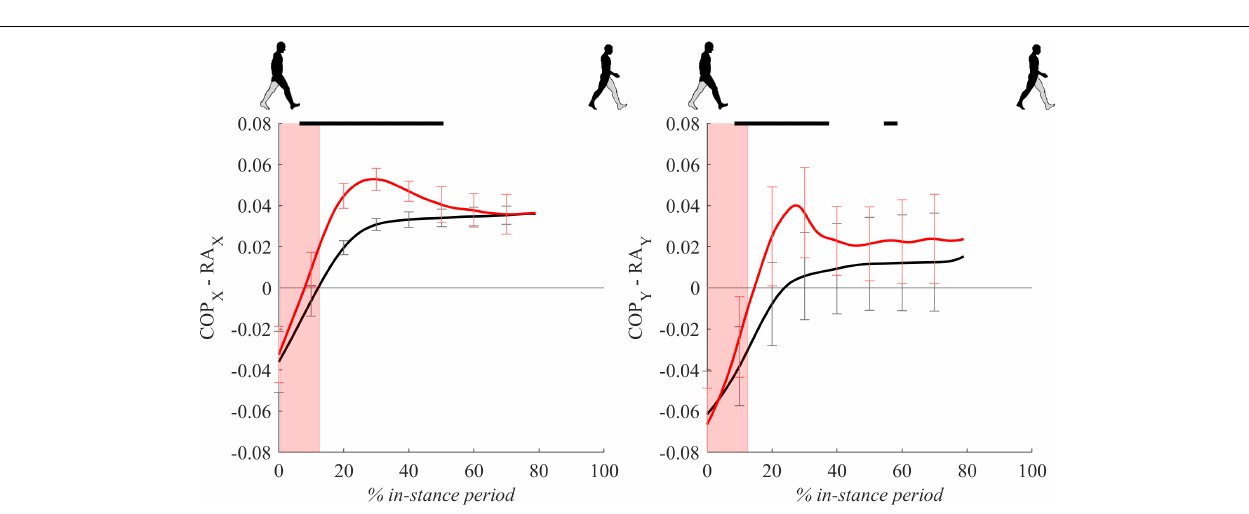
FIGURE 5 | Dimensionless group-average COP responses relative to the right ankle (medial malleolus) marker position (COPx – RAx and COPy – RAy) after outward perturbations ( N = 11). Standard deviations are shown at each 10% of a gait cycle. Black corresponds with the unperturbed experimental condition, red with perturbed experimental conditions. In-stance period, normalized to its duration separately for each experimental condition, is shown following a perturbing push. The perturbation period is marked with the red bar. Periods where statistically significant changes were determined between both experimental conditions are indicated with piece-wise continuous black lines on top of each